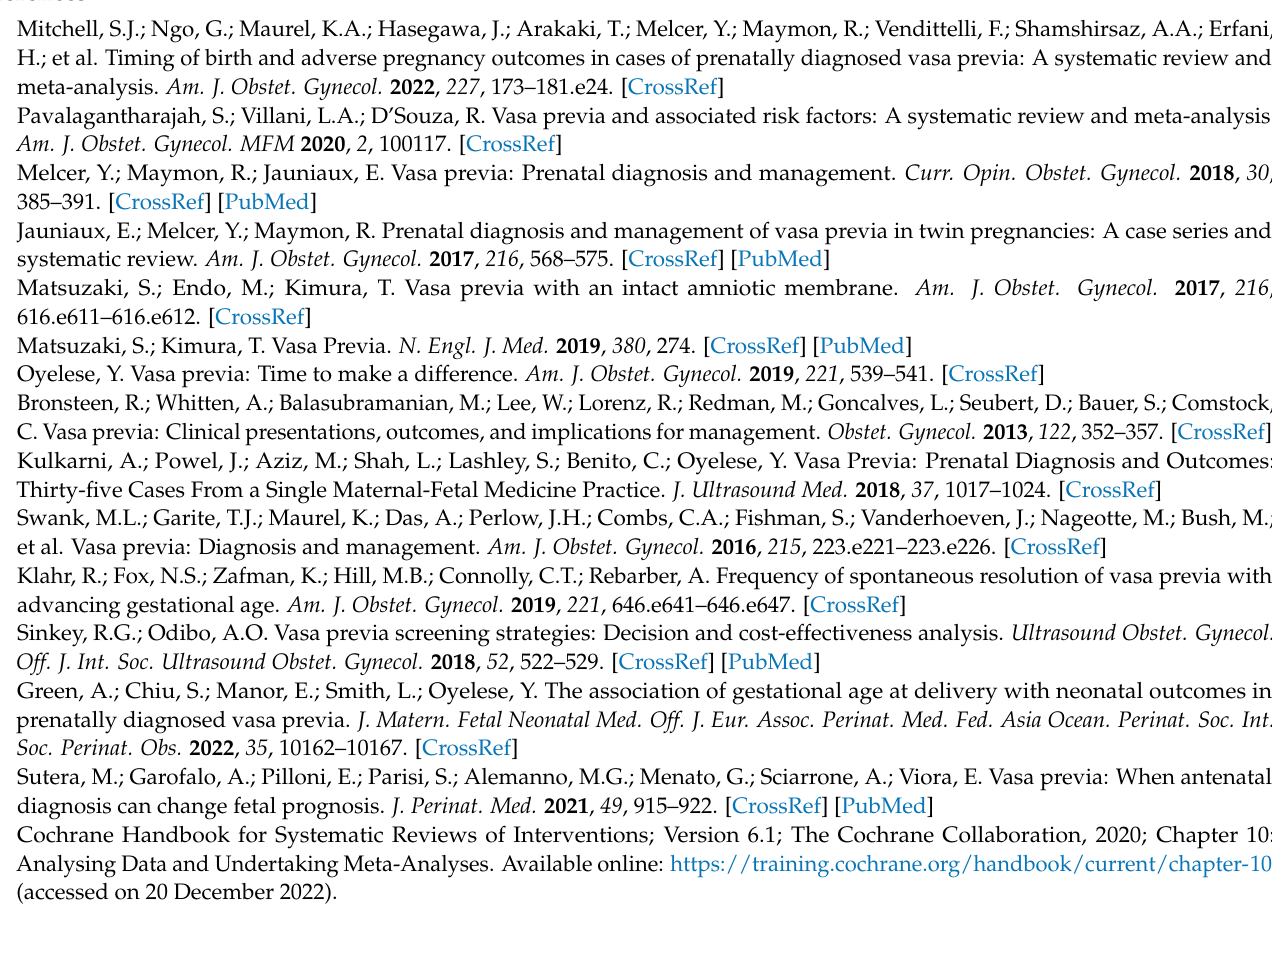
Table S2. Risk of bias assessment for the comparator